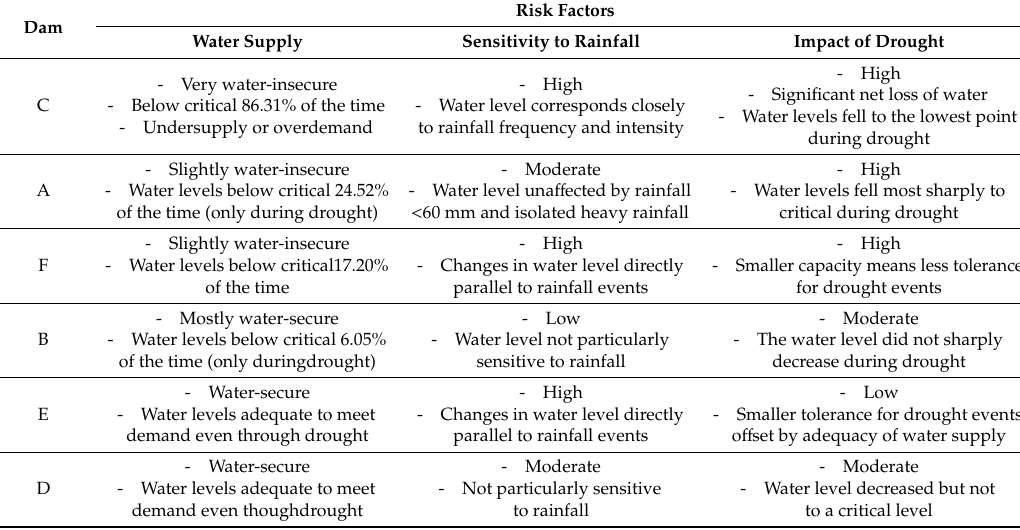
Table 2. Risk factor assessment based on drought impact and rainfall sensitivity for water supply. Risk Factors Dam Water Supply Sensitivity to